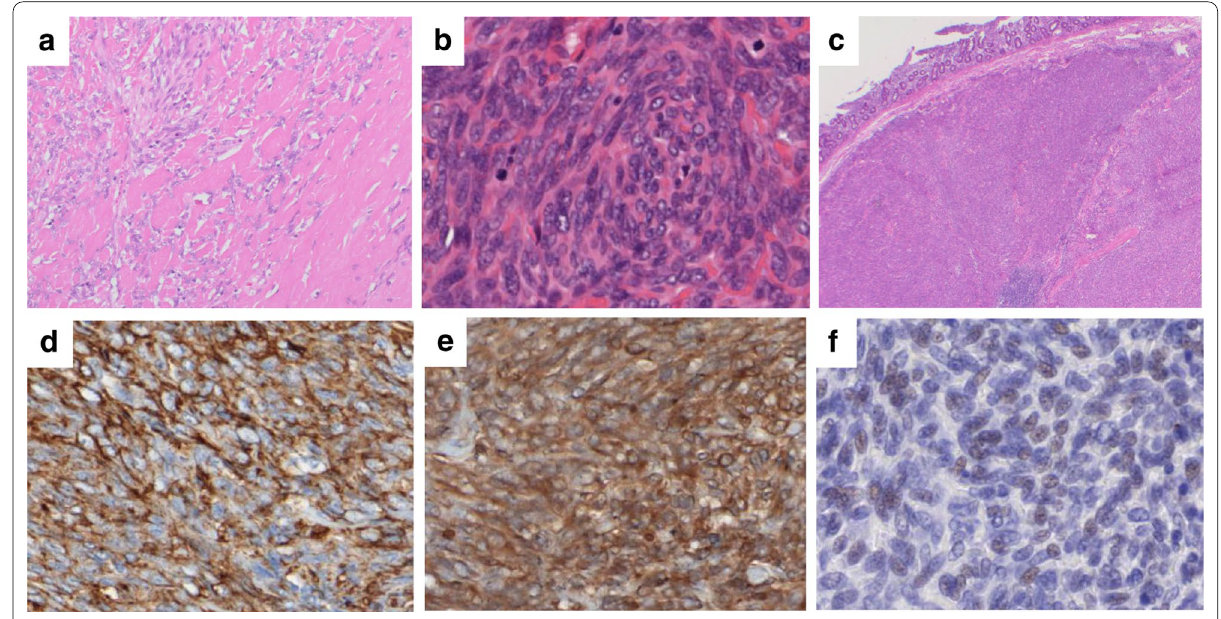
Fig. 5 Histopathological findings of the resected specimen. Invasive growth of proliferated spindle-shaped cells in the pancreatic tumor. Hyalinized fibrosis is present at the periphery of the tumor ( nuclear pleomorphism (increased N/C ratio) ( Immunohistochemically, the tumor cells were positive for CD34 (